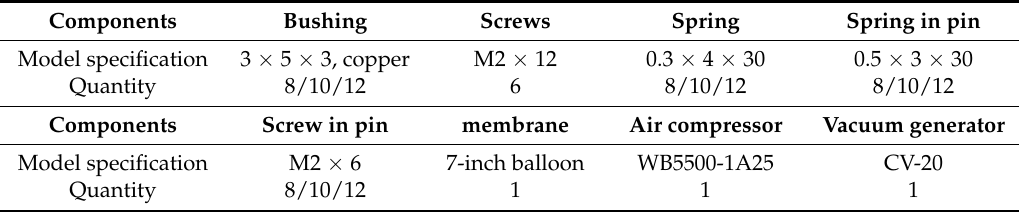
Table 3. The parameters of the components of CTSA-II hand.